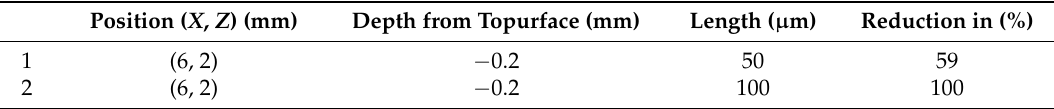
Table 4. The characteristics of the cracks modeled.